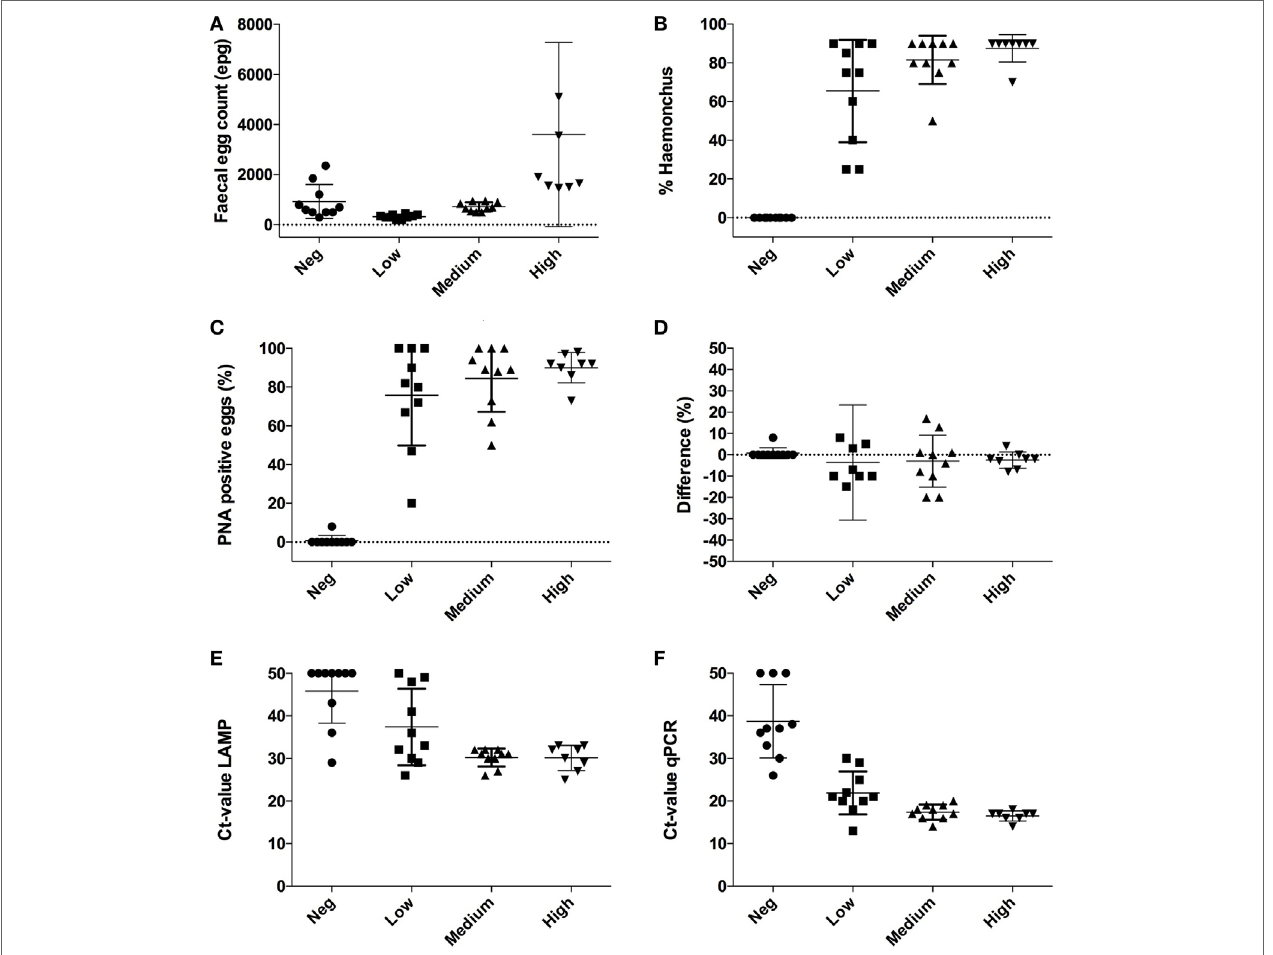
FigUre 1 | Individual results obtained with four different diagnostic methods applied to subsamples of fresh feces from 38 sheep. Samples were divided into four groups with samples from 8 to 10 sheep based on their nematode fecal egg count (FEC) and presence or absence of H. contortus following McMaster examination. (a) FEC expressed as eggs per gram feces (epg). Note one extreme value in the group “High” with 12,100 epg is outside the graph; (B) proportion of eggs identified as H. contortus in the McMaster chamber, (c) proportions of eggs in the samples that were stained with peanut agglutinin (PNA); (D) comparison between H. contortus -positive eggs with McMaster and following the PNA test; (e) cycle threshold (Ct) values with real-time quantitative polymerase chain reaction (qPCR); (F) Ct values with loop-mediated isothermal amplification (LAMP). For graphical reasons, negative results in both molecular tests are replaced with a Ct value of